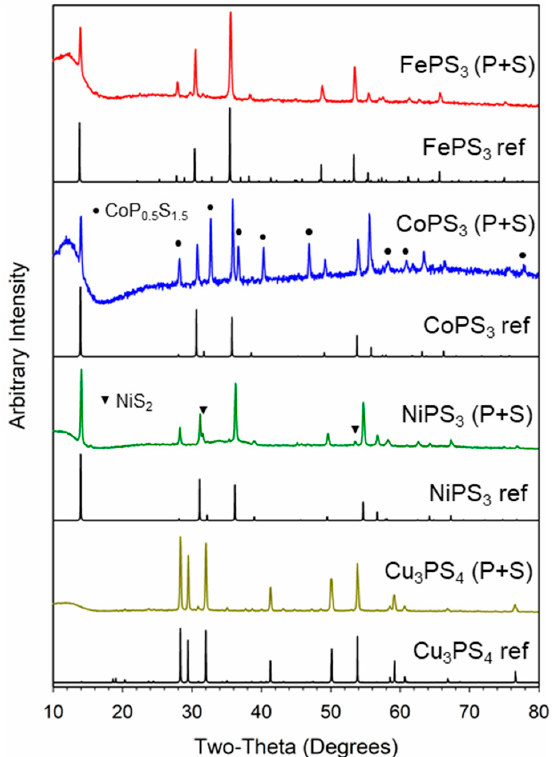
Figure 1. Powder X-ray diffraction results for MPS 3 (M = Fe, Ni, Co) and Cu 3 PS 4 products from the reaction of metal halides with elemental sulfur and phosphorus at 500 °C. Reference patterns (ref) are shown in black under each reaction product: Co 0.5 P 0.5 S 1.5 ( ) and NiS 2 ( ) impurities are identi- fied.